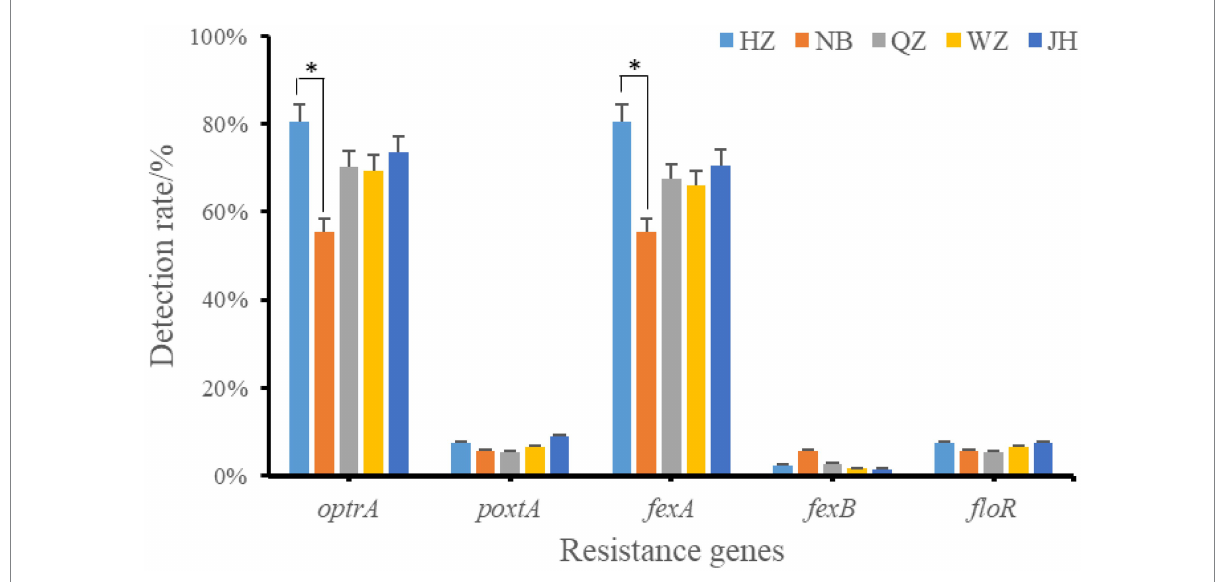
FIGURE 3 Positive rate of oxazolidinones and phenicoles resistance genes. * indicates that there is a significant difference between the two groups. HZ, Hangzhou; NB, Ningbo; QZ, Quzhou; WZ, Wenzhou; JH,